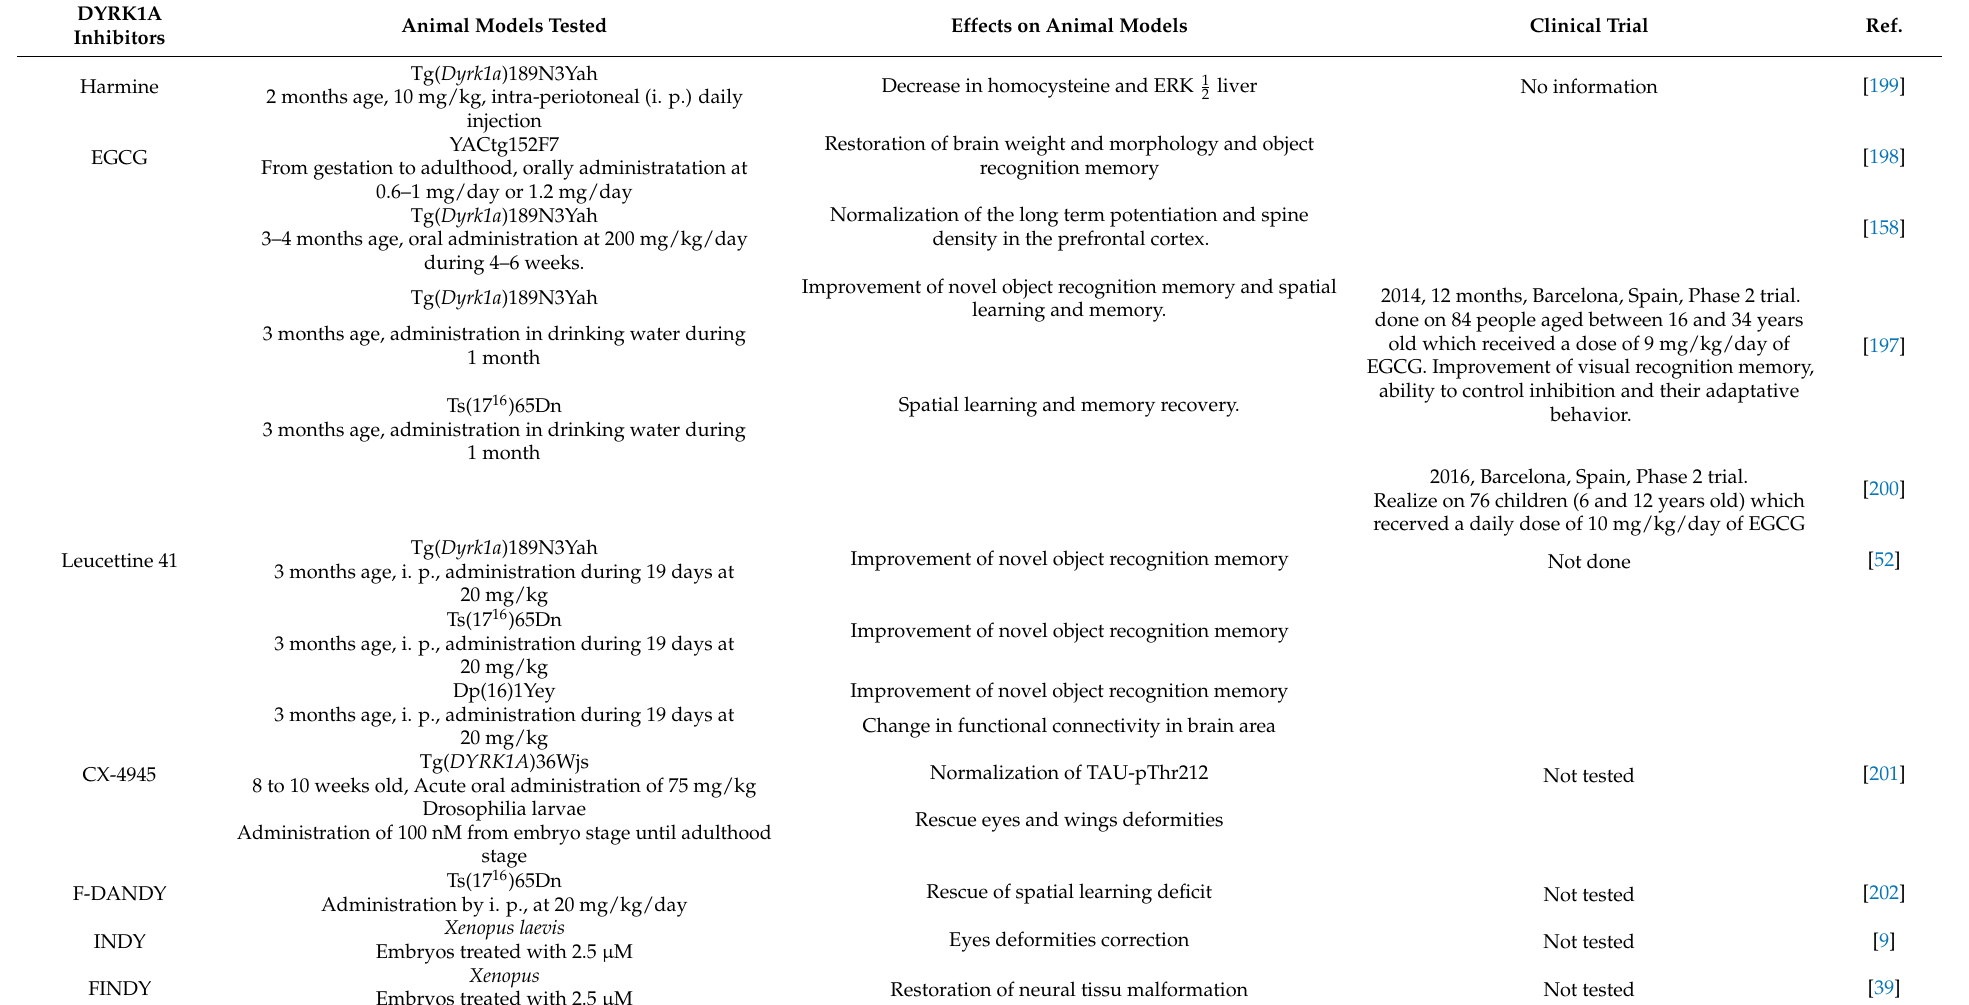
Table 3. Targeting DYRK1A activity using specific inhibitors in vivo with DS